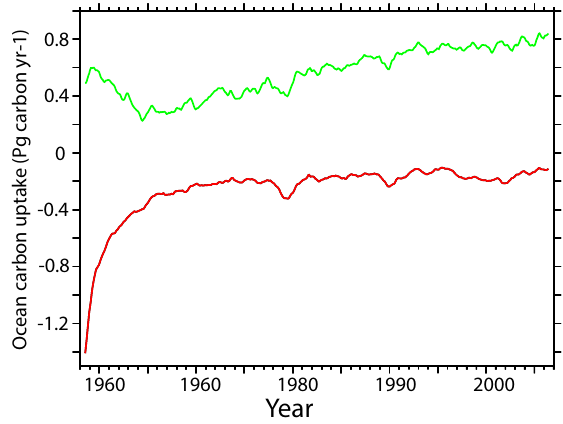
Figure 4. Interannually varying simulated CO 2 fluxes over 1958– 2006 as a 12-month running mean, with WSTIR in red and CNTRL in green; (units of PgCyr − 1 )